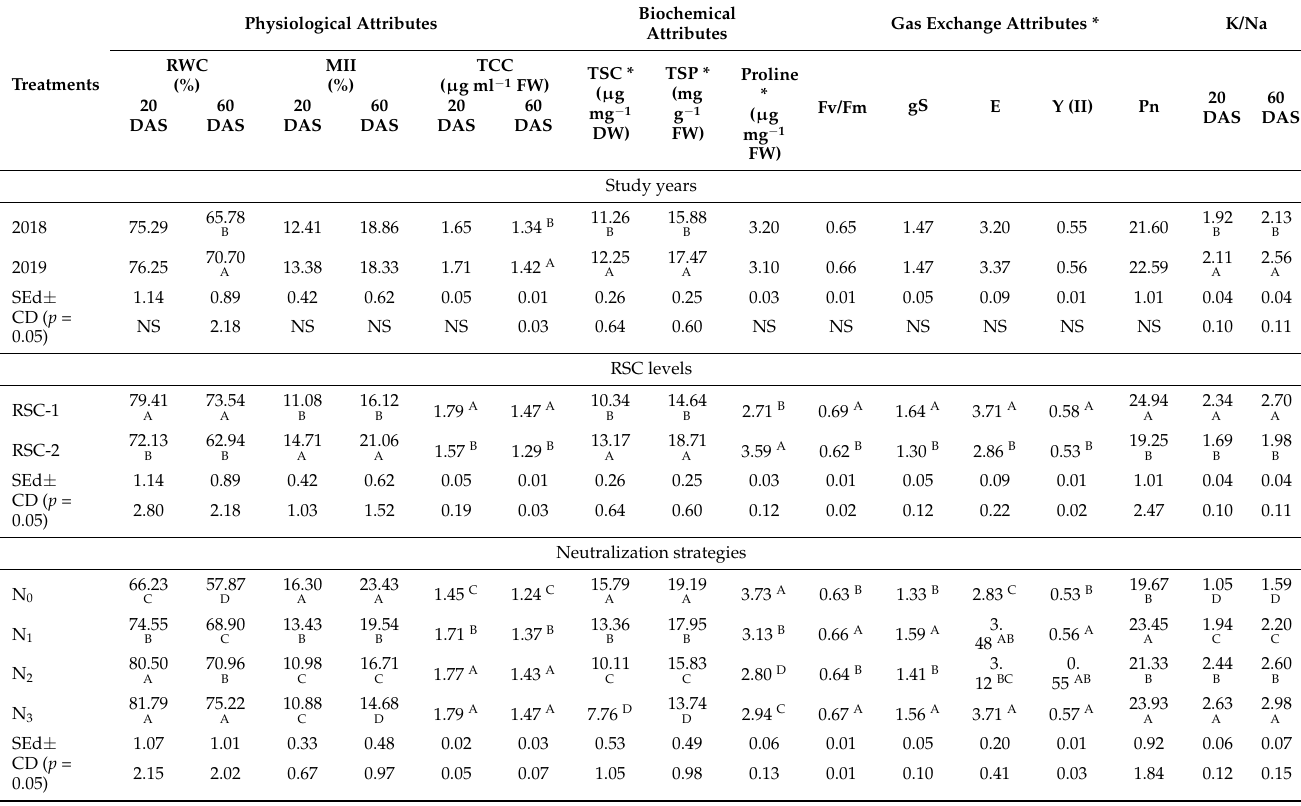
Table 2. Physiological, biochemical and gas exchange attributes of summer fodder sorghum as influenced by study years, RSC levels and neutralization